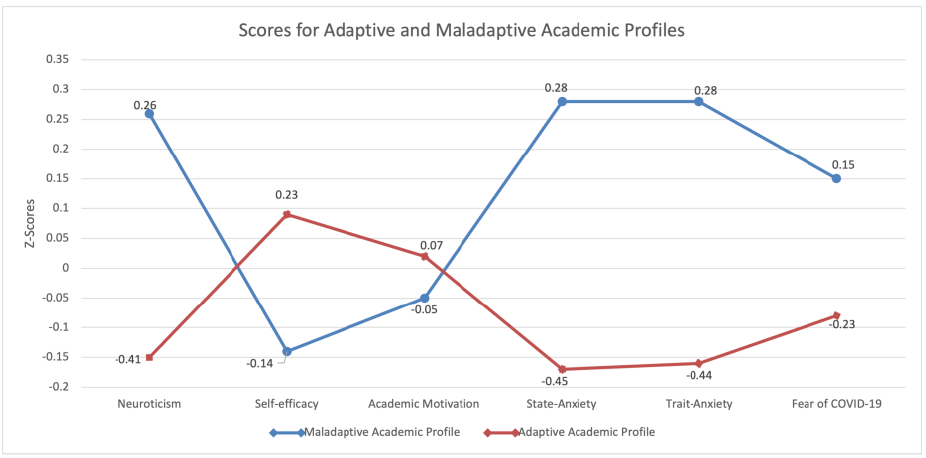
Figure 1. Z-scores for each studied variable for Adaptive and Maladaptive Academic Profiles.